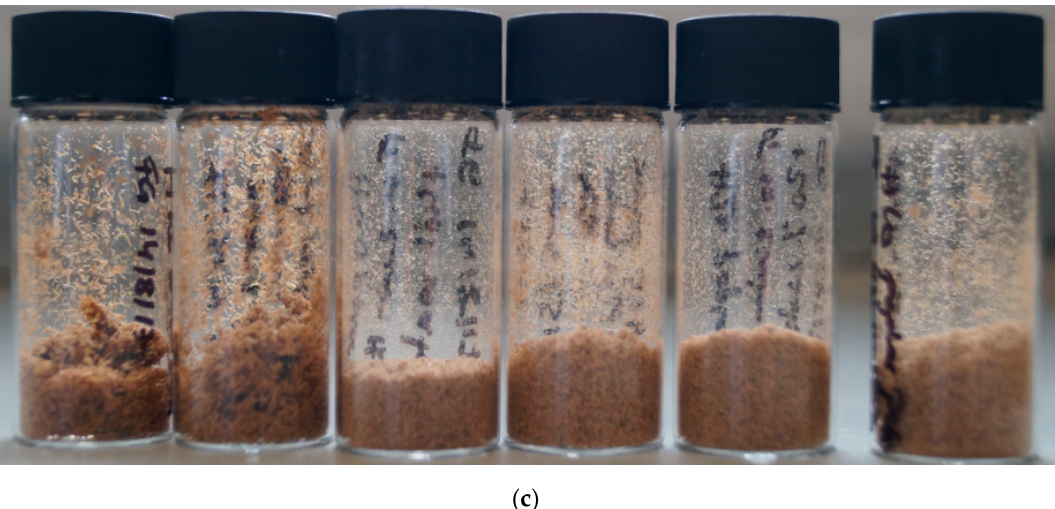
Figure 1. Poplar pulps isolated after pretreatment for 46 h at 100 °C with ( a ) [EMim][OAc], ( b ) [EMim][MeSO 3 ], and ( c ) [EMim][HSO 4 ] containing (from left to right) 0, 5, 10, 15, 20, and 40 wt% water.